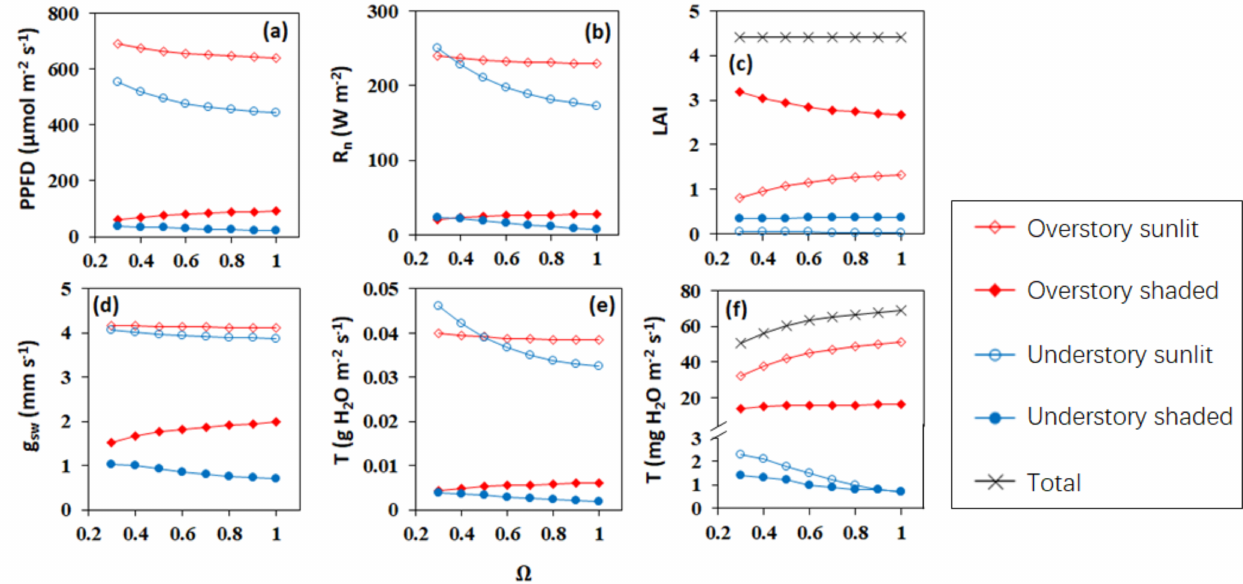
Figure 10. Variations of ( a ) PPFD, ( b ) R n , ( d ) g sw , ( e ) the leaf-level transpiration rate (T) for a representative sunlit and a representative shaded leaf in the overstory and understory canopies; ( c ) LAI and ( f ) canopy-scale transpiration rates (T) for overstory and understory canopies with Ω , when true LAI is used ignoring clumping (Case II). Overstory and understory LAI are set as 4.0 and 0.4, respectively, which are common in a typical conifer forest. θ = 45 ◦ . Ta = 15 ◦ C. Overstory canopy temperature = 14 ◦ C. Understory canopy temperature = 12 ◦ C. Ground temperature = 12 ◦ C. Relative humidity = 80%. Wind speed is set as 6.0 m s − 1 . Downward shortwave radiation above the canopy is set as 500 W m − 2 . The albedo of overstory and understory leaves in visible- and near-infrared bands are set as 0.035 and 0.23, respectively. The red open and filled diamonds represent the overstory sunlit and shaded components, respectively; the blue open and filled circles represent the understory sunlit and shaded components, respectively; the crosses represent the total of the four